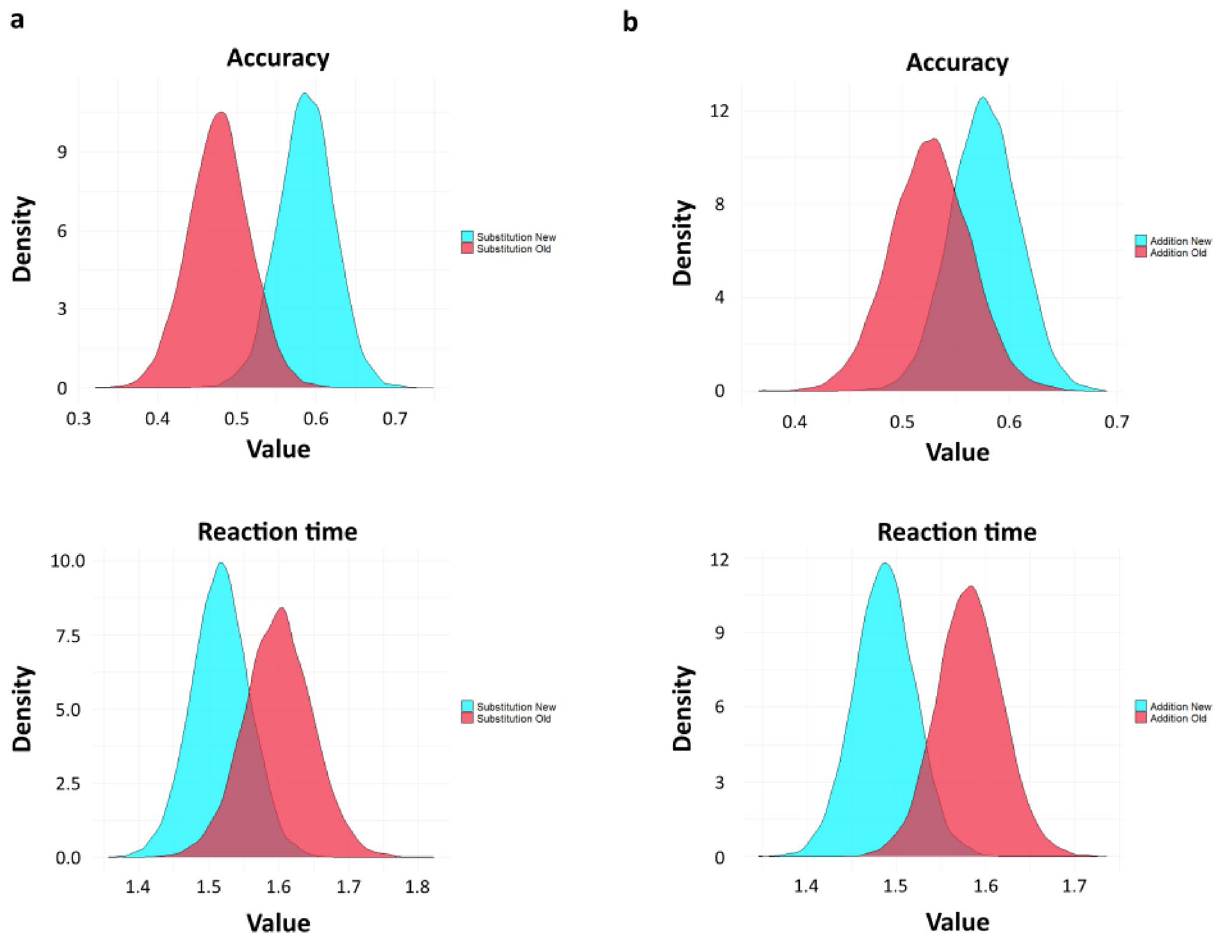
Figure 5. Posterior density estimates and Bayesian hypothesis testing. Posterior estimates of the main effects of temporal order memory. Bayesian hypothesis testing performed here is the posterior probability under the hypothesis against its alternative and is analogous to a one-tailed p -value. ( a ) Substitution. (Top) Posterior density estimates of the New and Old sequence showing high evidence of higher accuracy for the New sequence ( p = 0.98). (Bottom) Reaction times showing high evidence for New sequences being faster to recall than Old ( p = 0.95). ( b ) Addition. (Top) Much less evidence for the hypothesis that accuracy for the New sequence is